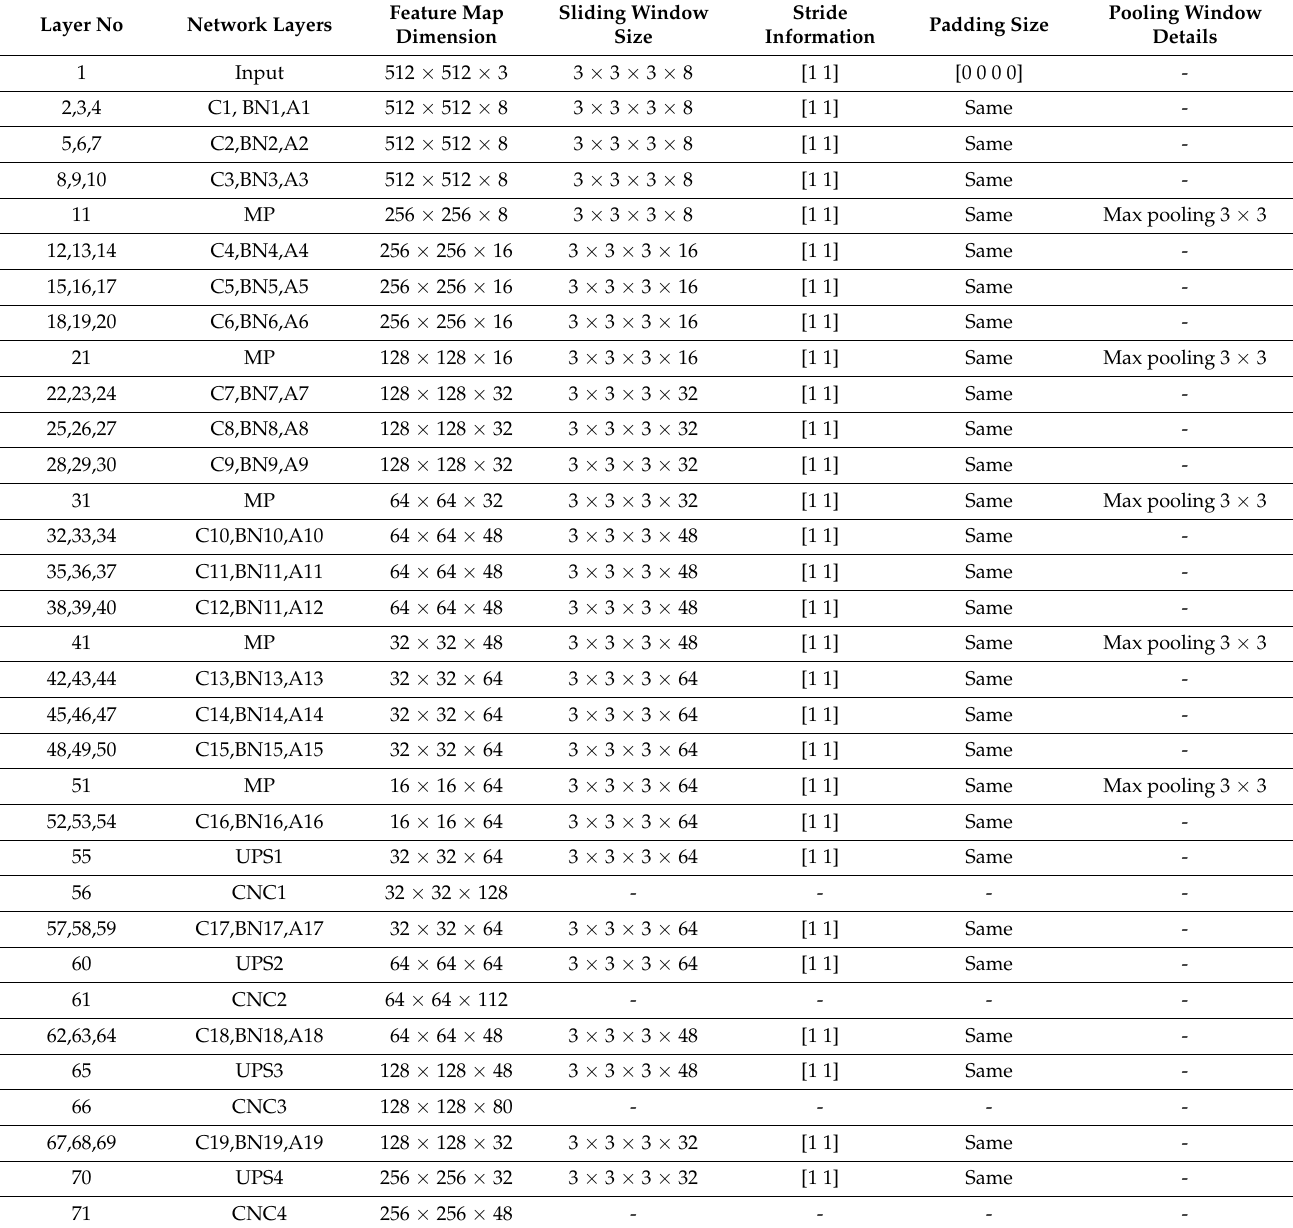
Table 2. Detailed layer information on the Graft-U-Net